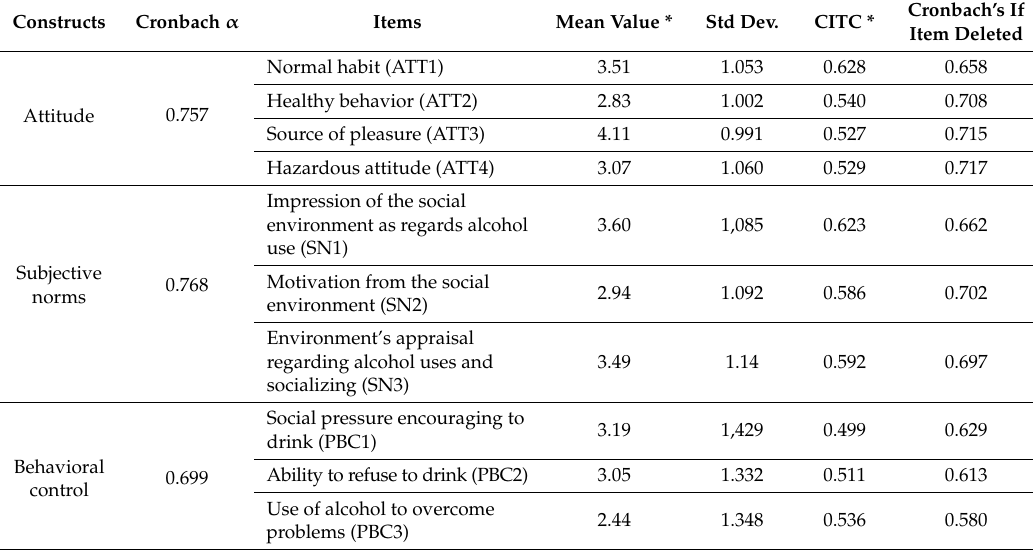
Table 3. Results of reliability analysis.